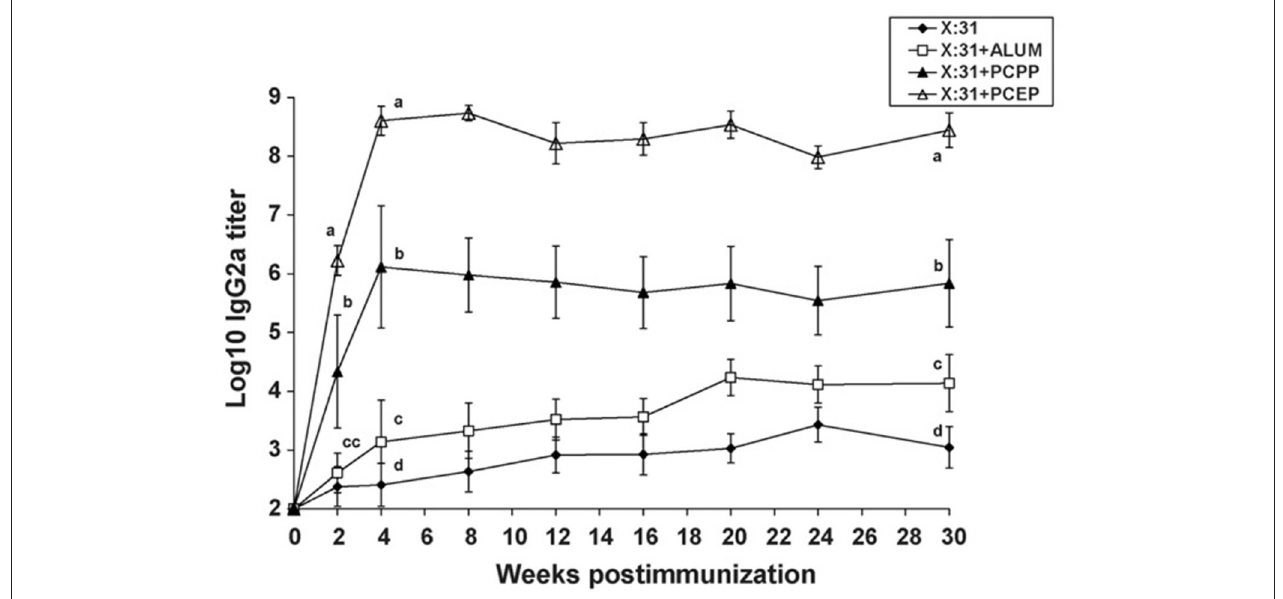
FIGURE 3 | Immune responses to low dose of influenza virus X:31 antigen: IgG2a antibody responses were assayed in serum of BALB/c mice ( n = 5 per group) given a single s.c. immunization with a low dose (0.2_g) of X:31 antigen alone, X:31 + alum, X:31 + PCPP or X:31 + PCEP. Each data point represents mean ± S.E.M. for titers as determined by ELISA. Groups with different letters are significantly different from each other ( p < 0.05). Data are representative of two independent experiments (reprinted from Mutwiri et al., 2007, Copyright 2007, with permission from Elsevier)